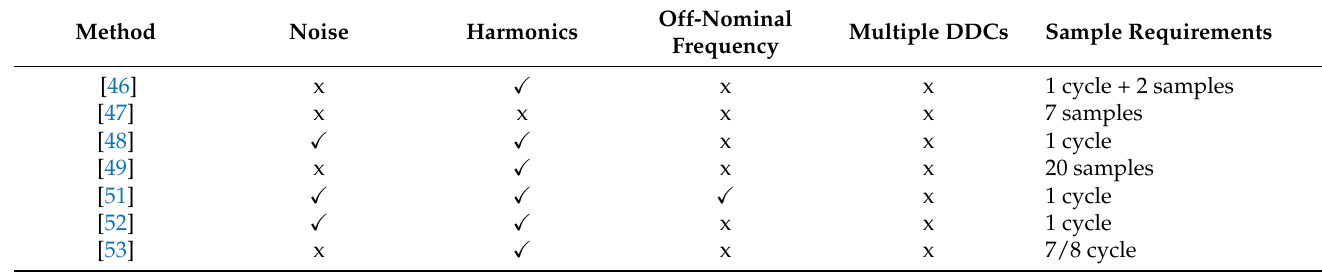
Table 5. Other methods—comparative analysis in the presence of destructive